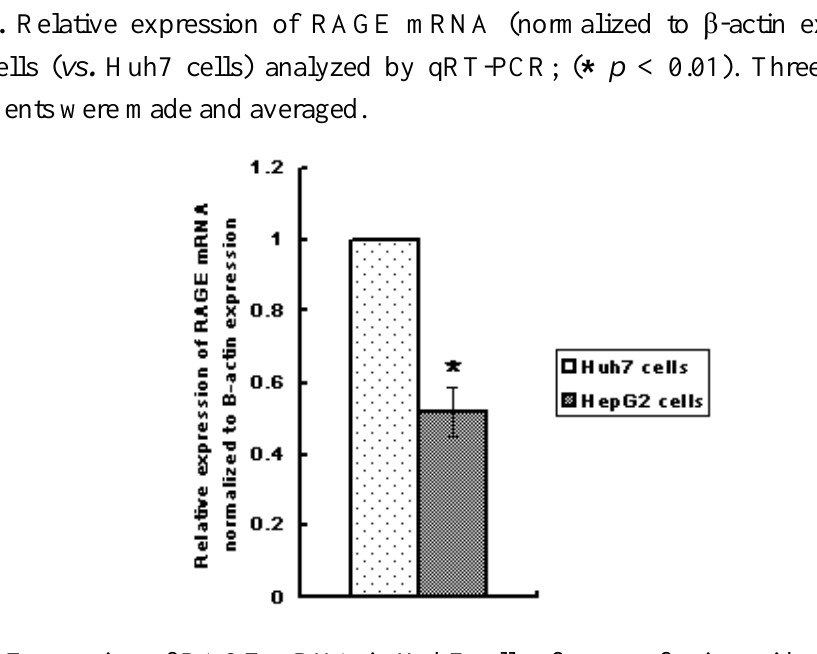
Figure 3. Expression of RAGE mRNA in Huh7 cells after transfection with three different RAGE siRNA; R1, R2, R3 and one negative control RNA (NC). ( a ) Relative expression of RAGE mRNA normalized to β-actin expression ( vs. blank control) analyzed by qRT-PCR; ( b ) Expression of RAGE protein by Western Blot; ( c ) Expression of RAGE protein as a ratio to β-actin. R3 showed the highest efficiency in inhibiting RAGE gene products ( * p < 0.01, # p < 0.01). Three independent measurements were made and